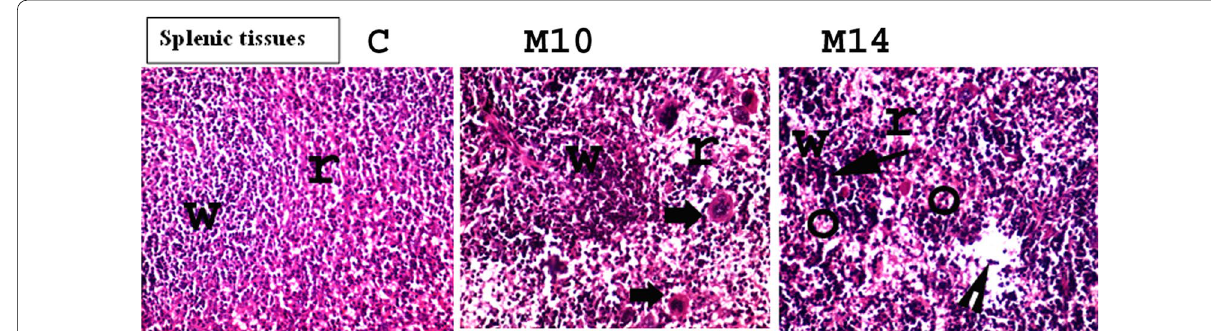
Fig. 2 A photomicrograph of splenic section. (C) Control group; (M10) monosodium glutamate treated mice for 10 days and (M14) monosodium glutamate treated mice for 14 days. White pulp (W) and red pulp (r); giant cells (thick arrow); diffused degenerated lymphoid cells (arrow); edema (o); necrotic foci filled by darkly stained cell (arrow head). H &E.X200